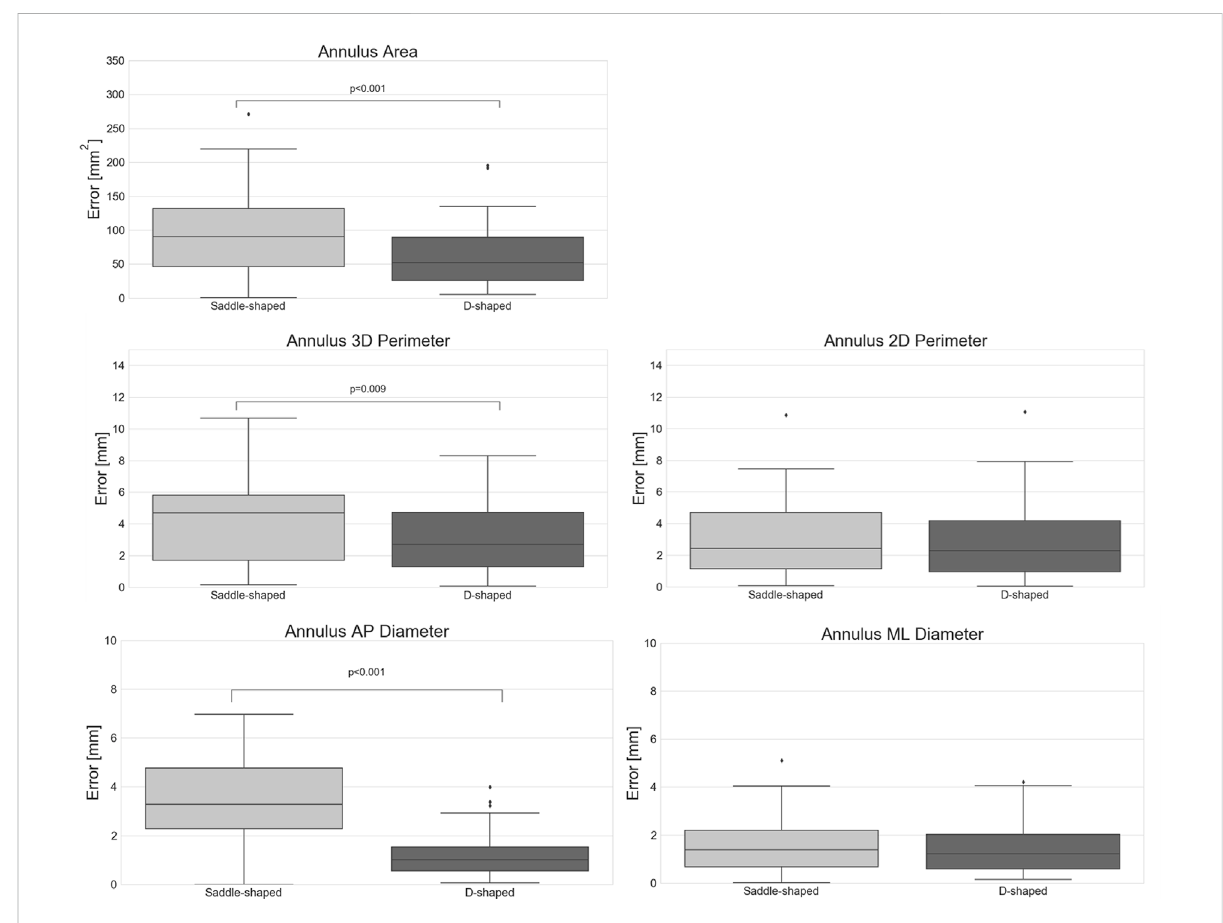
FIGURE 6 Absoluteerroroftheautomaticallypredictedannulusmeasurementsforthesaddle-andD-shapedannulus( p -valuesareshownforstatistically signi fi cant differences between the saddle- and D-shaped annulus